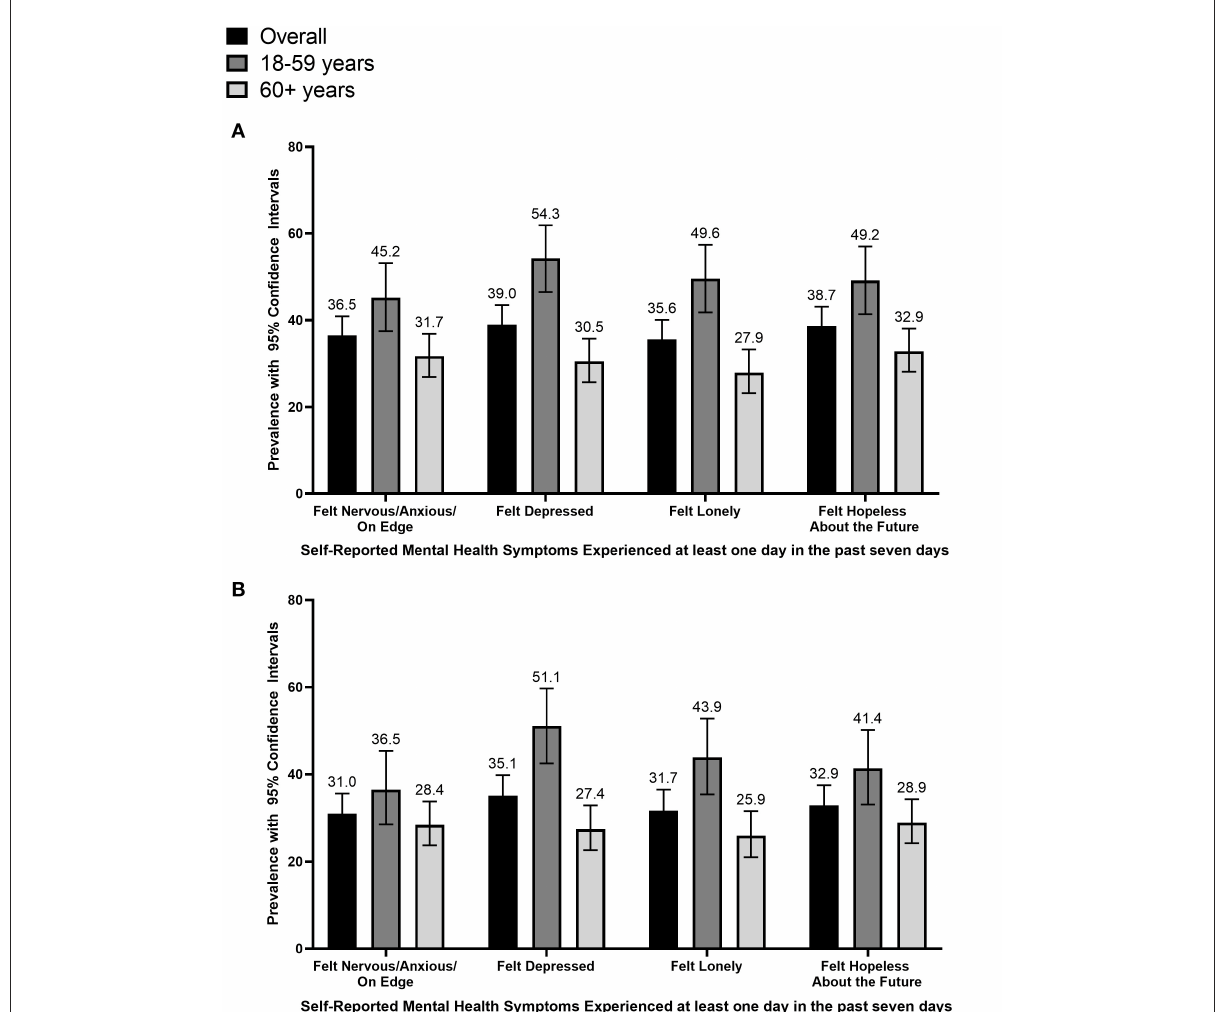
FIGURE1 Prevalence of mental health symptoms among cancer survivors stratified by age group, COVID-19 Household Impact Survey (April–June 2020) ( n = 854). This figure summarizes the prevalence of mental health symptoms experienced at least one time in the past seven days, specifically among (A) all cancer survivors and (B) cancer survivors without a diagnosed mental health